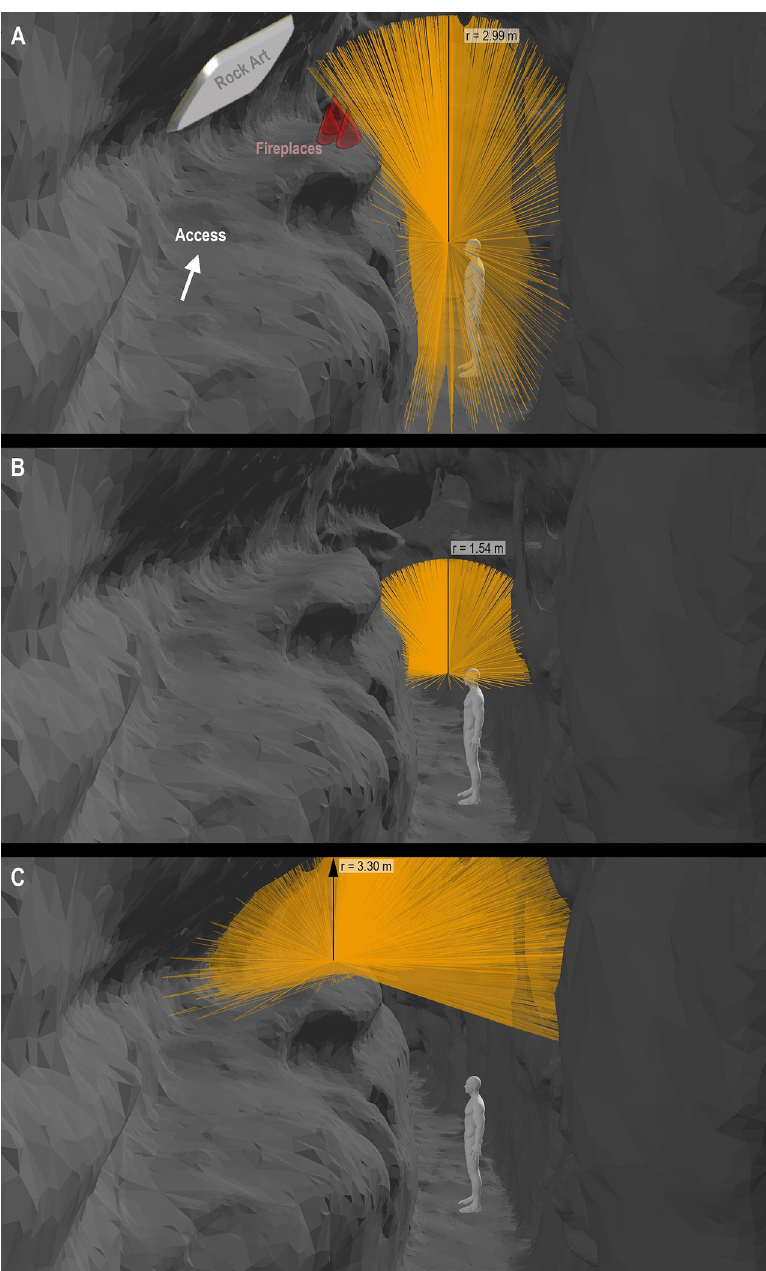
Fig 9. Representation of the range of the illuminance (lux) of the three analyzed lighting systems. A. Wood torch. B. Portable grease lamp. C. Fireplaces with wood fuel. (Measurements made in ArcScene ™ by ArcGis 1 based on the data from the